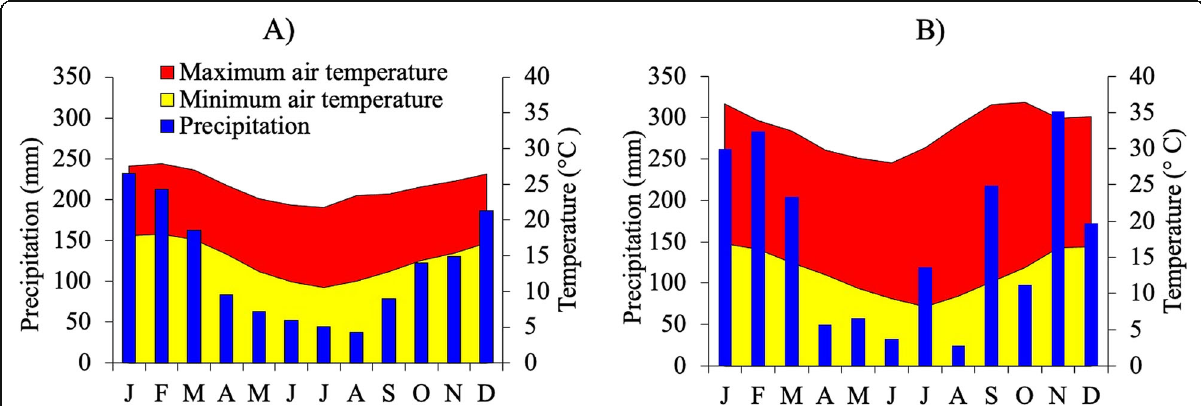
Fig. 1 a Historical series (1933 – 2014) for average accumulated pluviometric precipitation values, and maximum and minimum air temperatures